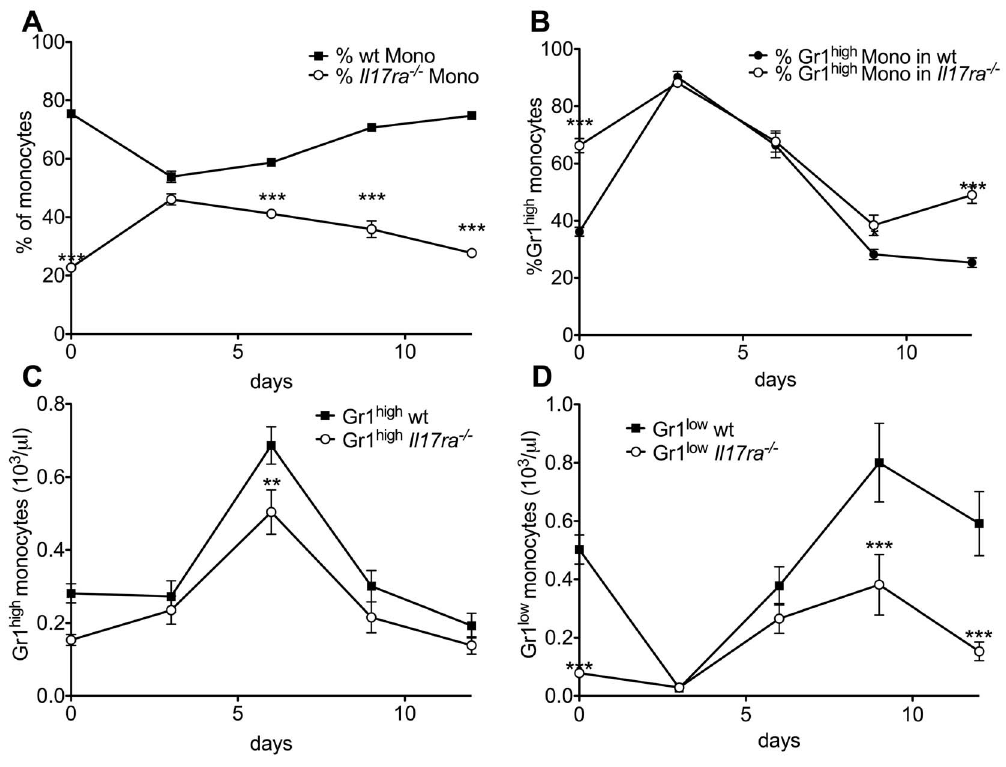
Figure 6. Lack maintenance of Il17ra -/- Gr1 low monocyte population after normal initial recovery. ( A-D ) Mixed bone marrow chimeric wt/ Il17ra -/- mice underwent monocyte depletion by liposomal clodronate. During recovery, monocyte genotype (A), proportion of Gr1 high and Gr1 low cells among the monocytes of each genotype (B) and absolute blood concentrations of Gr1 high (C) and Gr1 low monocytes (D) of each genotype were measured (n=8, 2 independent transplantations, Bonferroni after two-way-ANOVA).